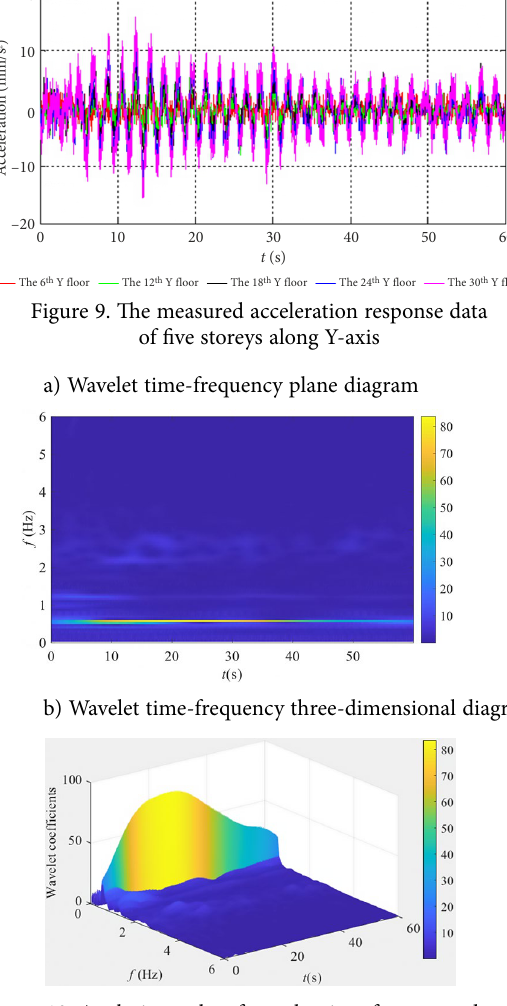
Figure 10. Analysis results of wavelet time-frequency